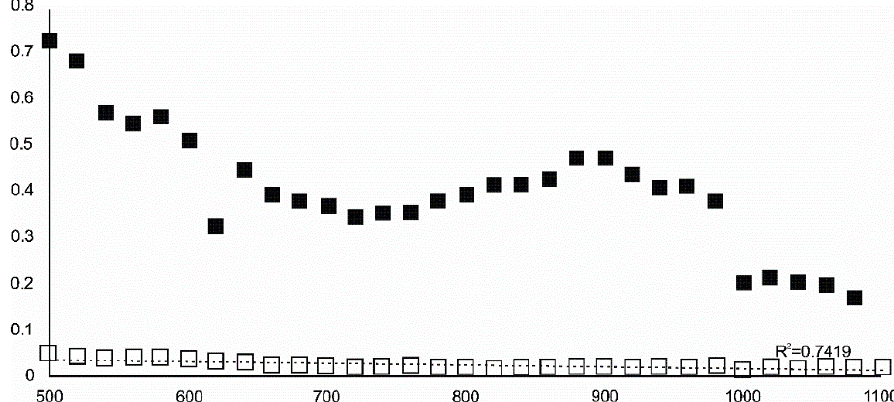
Figure 14. Relation of temperature (bottom axis, in °C) to FWHM (left axis, as 2 θ angular difference) for magnetite. LSCB sample—filled symbols. USCB sample—empty symbols. Squares—heating-related data. Triangles—cooling-related data. Data calculation was based on the main reflection.